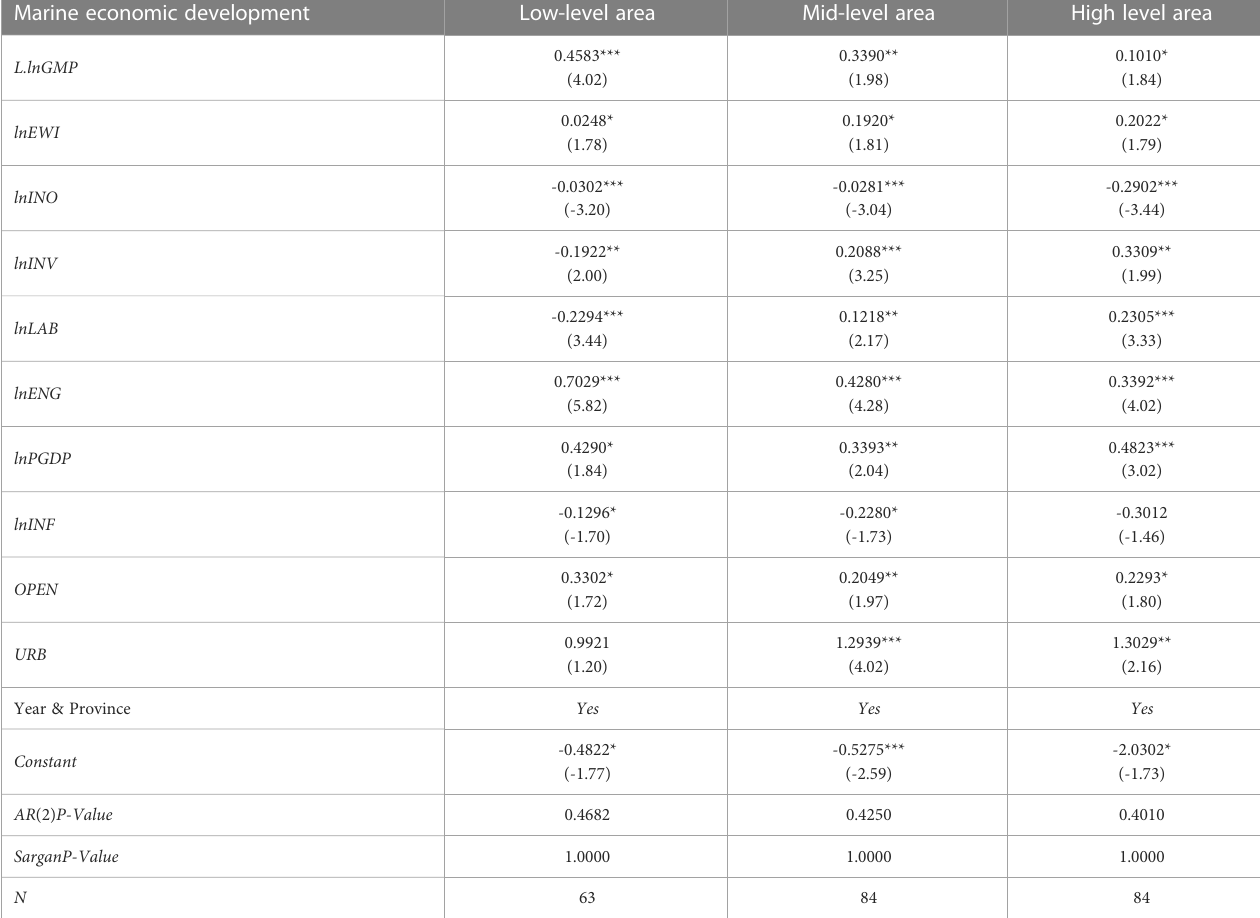
TABLE 5 Regional heterogeneity analysis of economic development